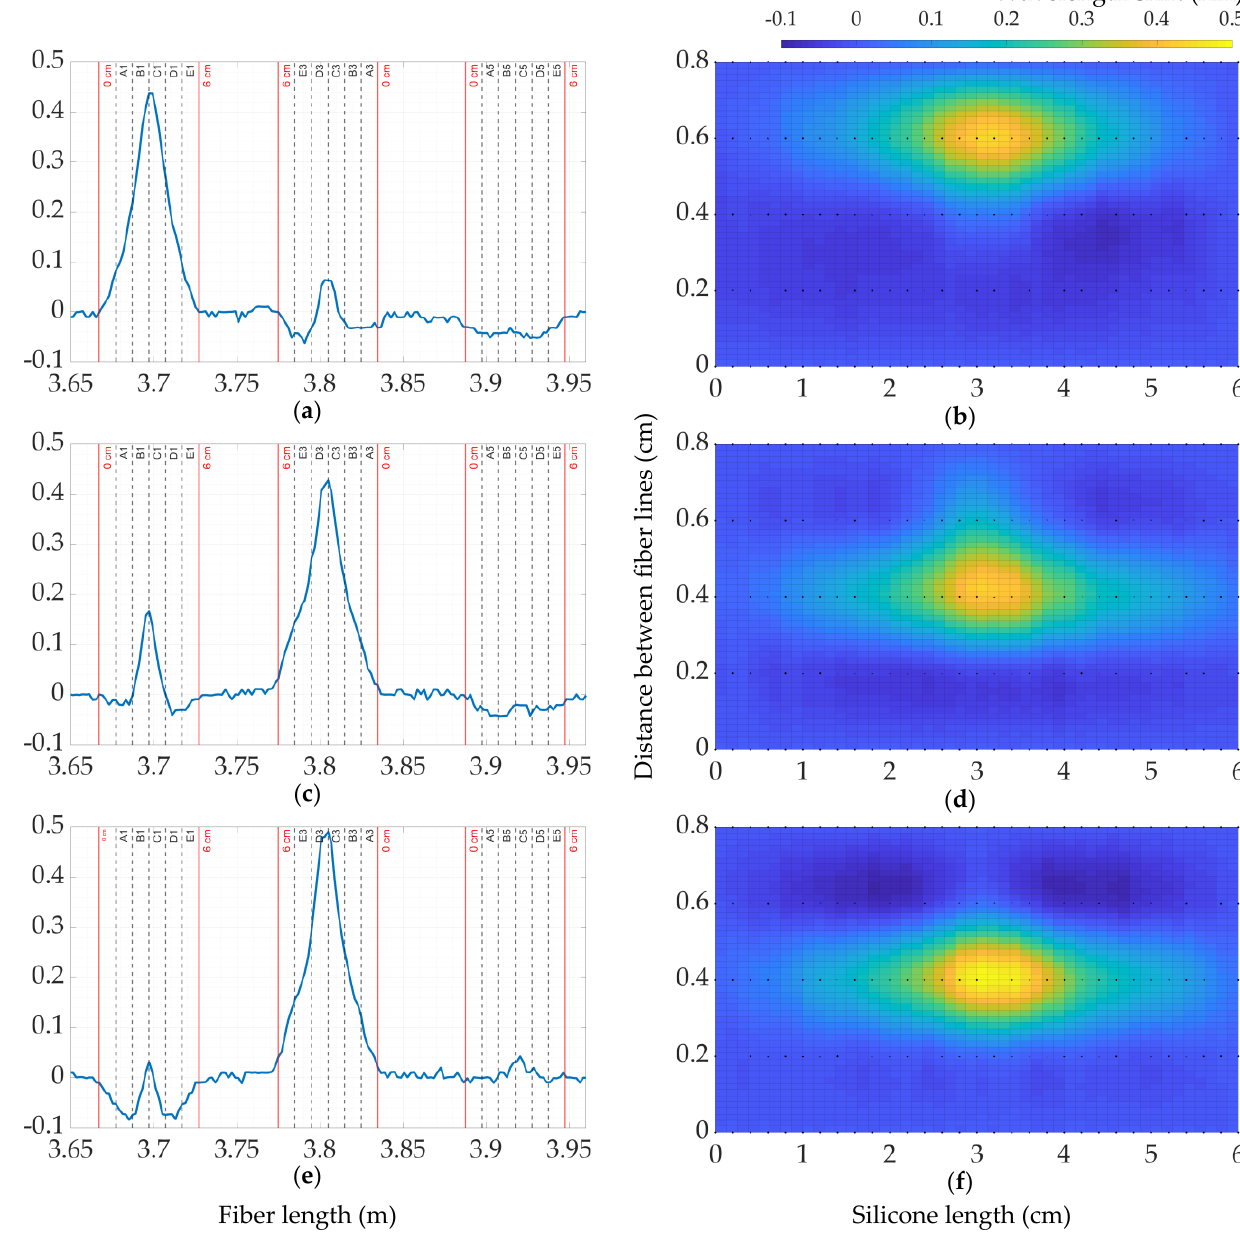
Figure 8. Plots and 2D maps of a wavelength shift to 550 g load: ( a , b ) position “C1”; ( c , d ) position “C2”; ( e , f ) position “C3”.